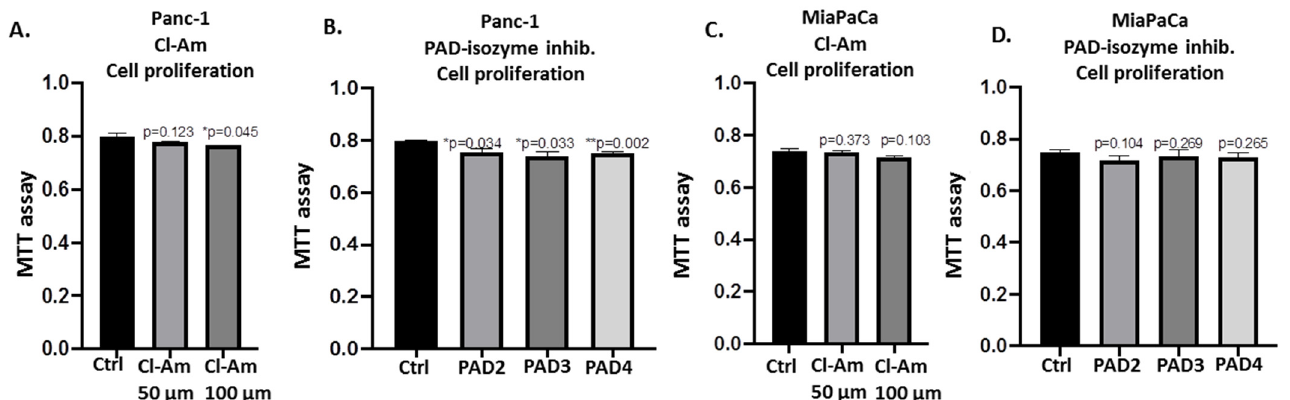
Figure 12. Cellular proliferation following Cl-amidine and/or PAD2, 3, 4 isozyme-specific inhibitor treatment in Panc-1 and MiaPaCa-2 cells. MTT assay showing cell proliferation after 1 h treatment with Cl-Am (50 and 100 µ m) shows little effect on either Panc-1 ( A ) or MiaPaCa-2 cells ( C ), albeit in some cases statistical significance is reached. Similarly, PAD2 (5 µ m), PAD3 (10 µ m), and PAD4 (10 µ m) inhibitors did not show marked changes on cell proliferation in Panc-1 cells ( B ) or MiaPaCa-2 cells ( D ) following 1 h treatment. Exact p -values are indicated ( * p ≤ 0.05; ** p ≤